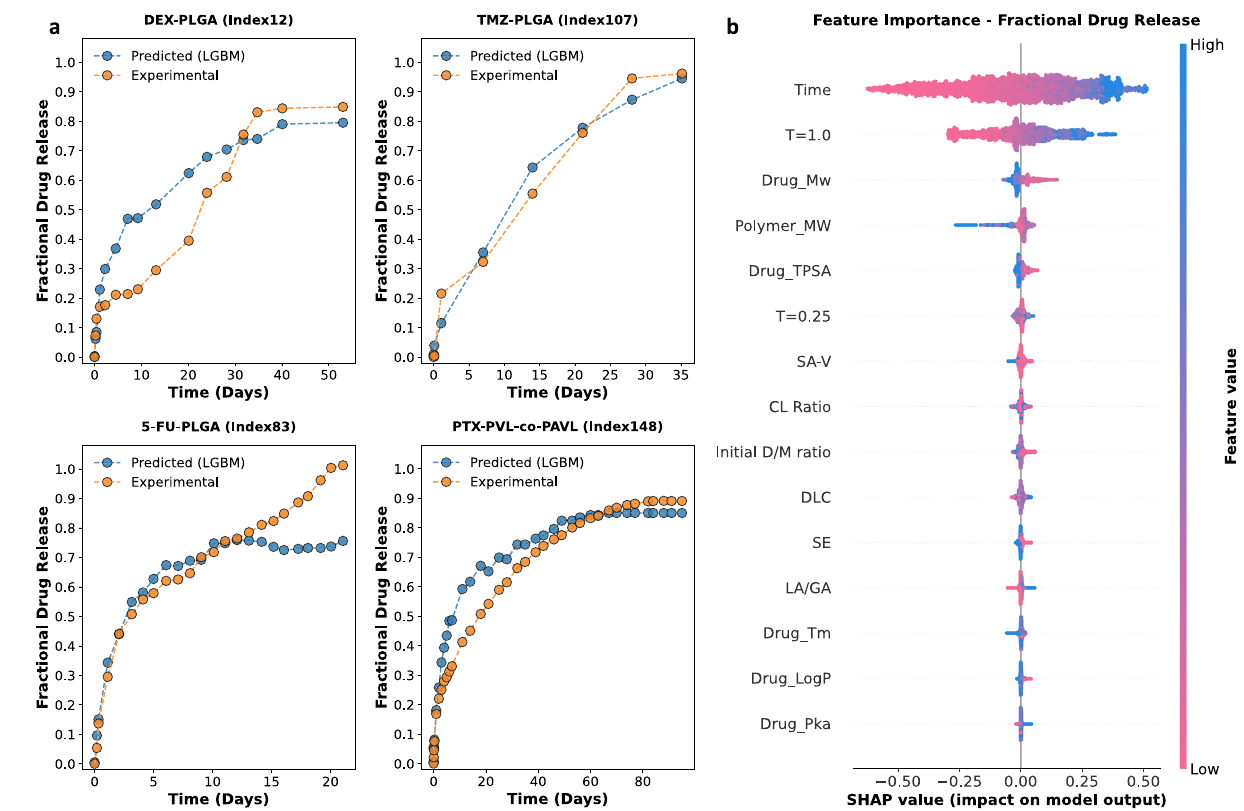
Fig. 4 | Deployment of the trained 15-feature lightGBM (LGBM) model. a Select examples of experimental fractional drug release pro fi les (orange circles) in com- parisontopredicted fractionaldrug release pro fi les(blue circles)generated bythe LGBM model. These include dexamethasone-loaded PLGA MPs (DEX-PLGA); temozolomide-loaded PLGA MPs (TMZ-PLGA); fl uorouracil-loaded PLGA MPs (5- FU-PLGA); and paclitaxel-loaded PVL-co-PAVL cross-linked cylinders. b Shapley additiveexplanations(SHAP)analysisforthe15-featureLGBMmodel.Theimpactof